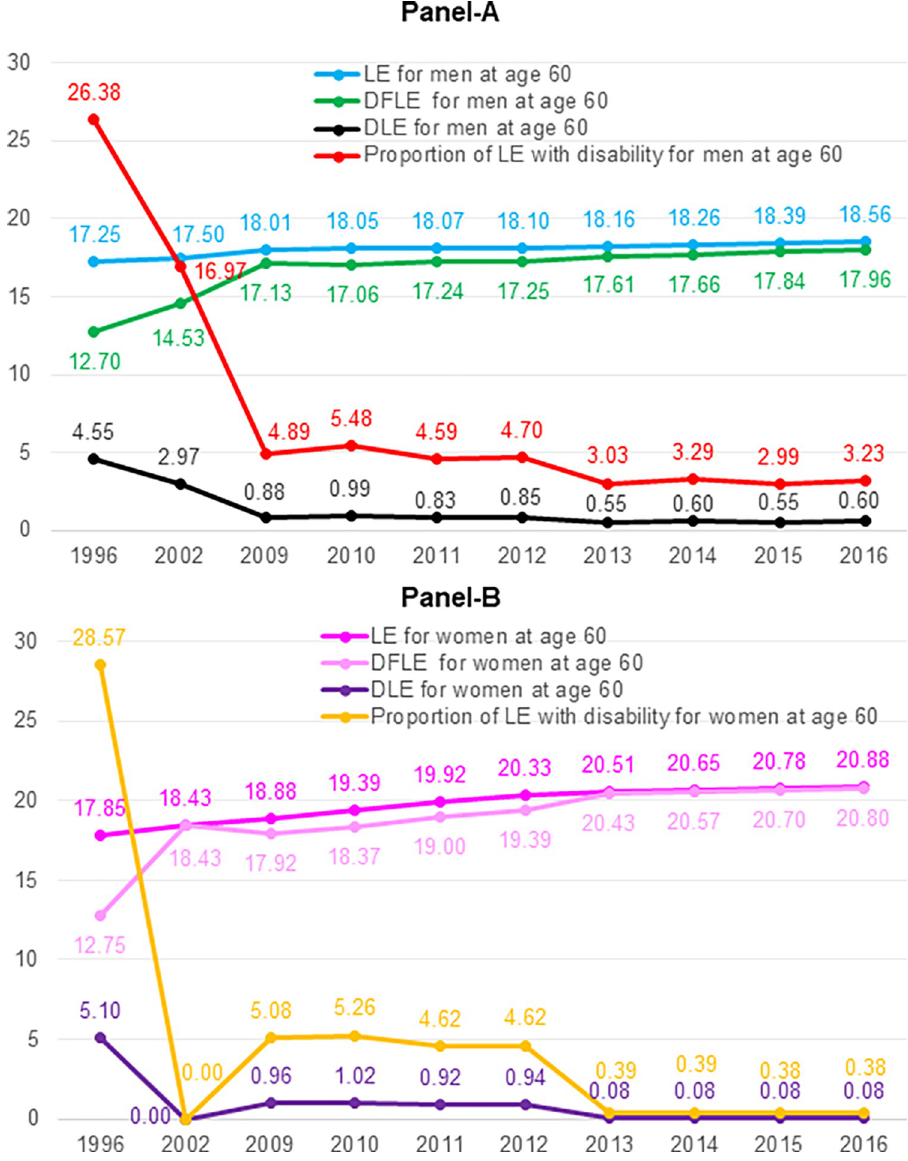
Fig 3. Health expectancy by gender at age 60 from 1996 to 2016 † . Notes: † For 1996 and 2002, DFLE represents life expectancy with good self-reported health; DLE represents life expectancy with poor self-reported health; DFLE: Disability-free life expectancy; DLE: Life expectancy with disability; LE: Life expectancy.